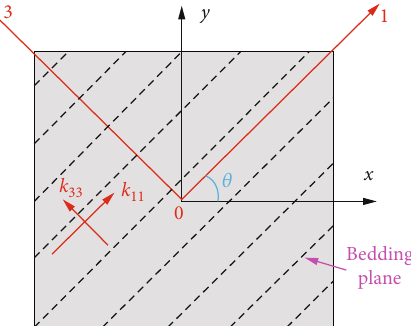
Figure 4: Schematic diagram of the relationship between the main direction of penetration and strati fi